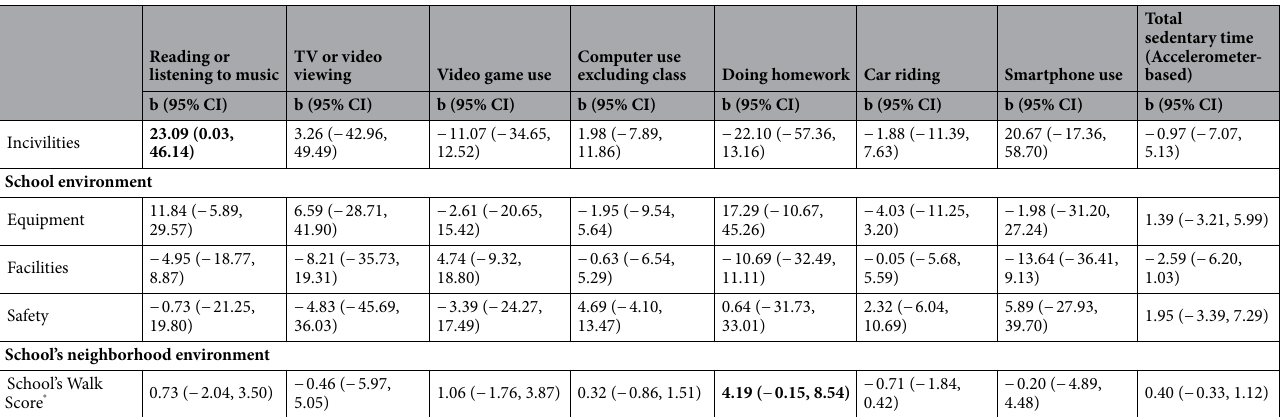
Table 2. Individual regression models for correlates of domain-specific sedentary behaviors and objectively assessed sedentary time among children. b = unstandardized regression coefficients; CI Confidence interval. All models adjusted for children’s age, sex, BMI, annual household income, and locality. Bolded data indicate significance ( p <